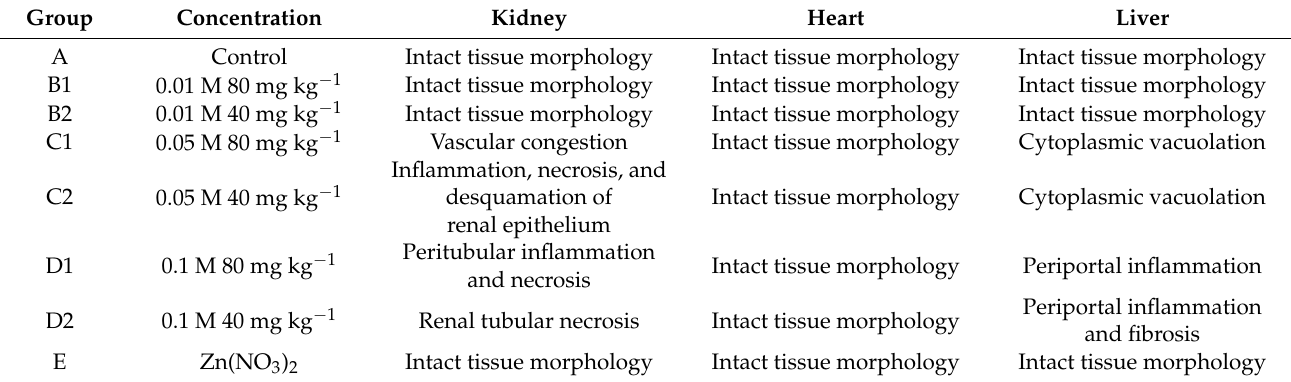
Table 2. The summary of histopathological examination of renal, cardiac and hepatic tissues.